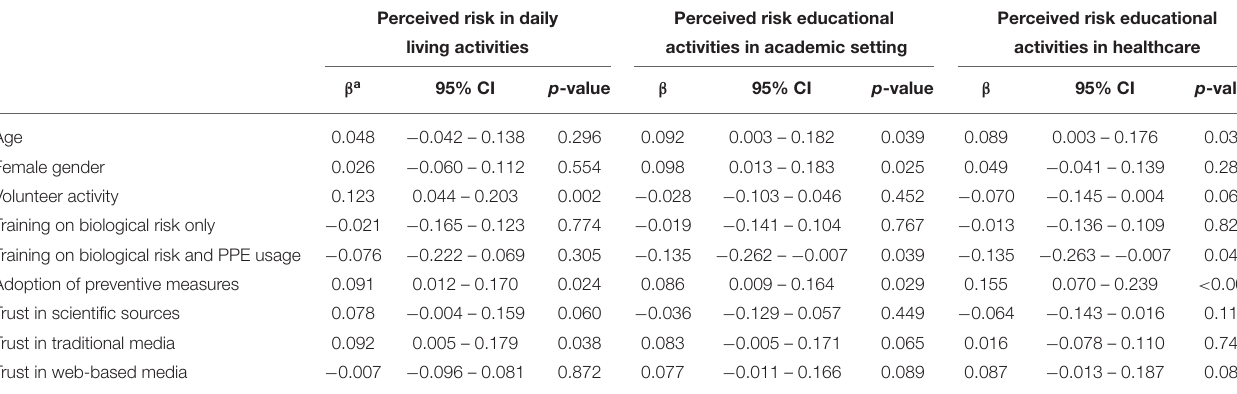
TABLE 2 | Fully saturated path model estimates.